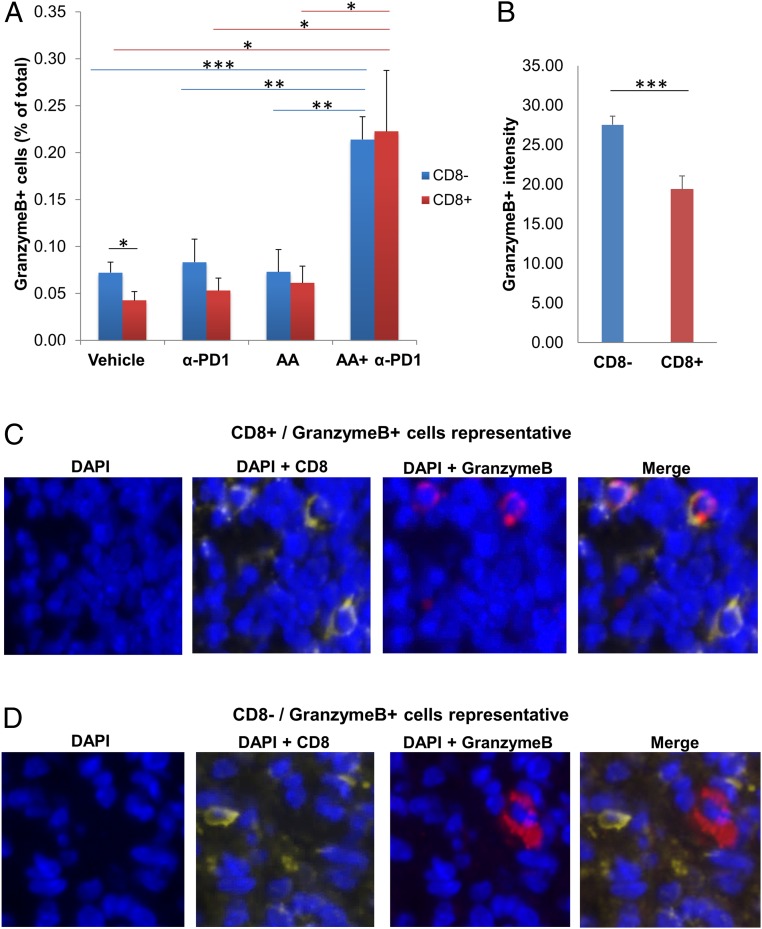
High-dose AA and anti-PD1 treatment combination activates cytotoxic CD8+T cells and cytotoxic NK cells/CD8− T cells. The contribution of NK cells/CD8− T cells toward net granzyme B production is more than CD8+ T cells. (A) Mouse tumors were costained with CD8 and granzyme B. The percent CD8−/granzyme B+ percent positive cells (representing NK cells/CD8− T cells with granzyme B) was not significantly different from the CD8+/granzyme B+ percent positive cells (representing CD8+ T cells with granzyme B) within each of 3 treatment groups: AA, anti-PD1, AA+anti-PD1. In the vehicle group, CD8−/ granzyme B+ percent positive cells was higher than CD8+/granzyme B+ percent positive cells (P = 0.038). The CD8+/ granzyme B+ cell count in the AA+α-PD1 group was significantly higher than in vehicle (P = 0.012), single-agent AA (P = 0.021), and single-agent α-PD1 (P = 0.016). Similarly, CD8−/granzyme B+ cell count in the AA+α-PD1 group was significantly higher than in vehicle (P < 0.001), single-agent AA (P = 0.002), and single-agent anti-PD1 (P = 0.003). Immunofluorescence images were captured at 50× magnification. *P < 0.05; **P < 0.005; ***P < 0.001. (B) Intensity of granzyme B staining within the CD8− cells across all treatment groups was significantly higher than within the CD8+ cells (P < 0.001). Data expressed as means ± SEM of 5 representative mouse tumors per treatment group; all tumors were harvested on day 19 (day 9 after treatment initiation). ***P < 0.001. (C and D) Magnified (80×) images of dual CD8 and granzyme B costain showing representative pictures of individual CD8+/granzyme B+ cells (C) and CD8−/granzyme B+ cells (D). The amount of granzyme B within CD8− cells appears to be much higher than within CD8+ cells, explaining the difference in intensity calculated in B. Immunofluorescence staining was quantified by artificial intelligence technology (A and B).